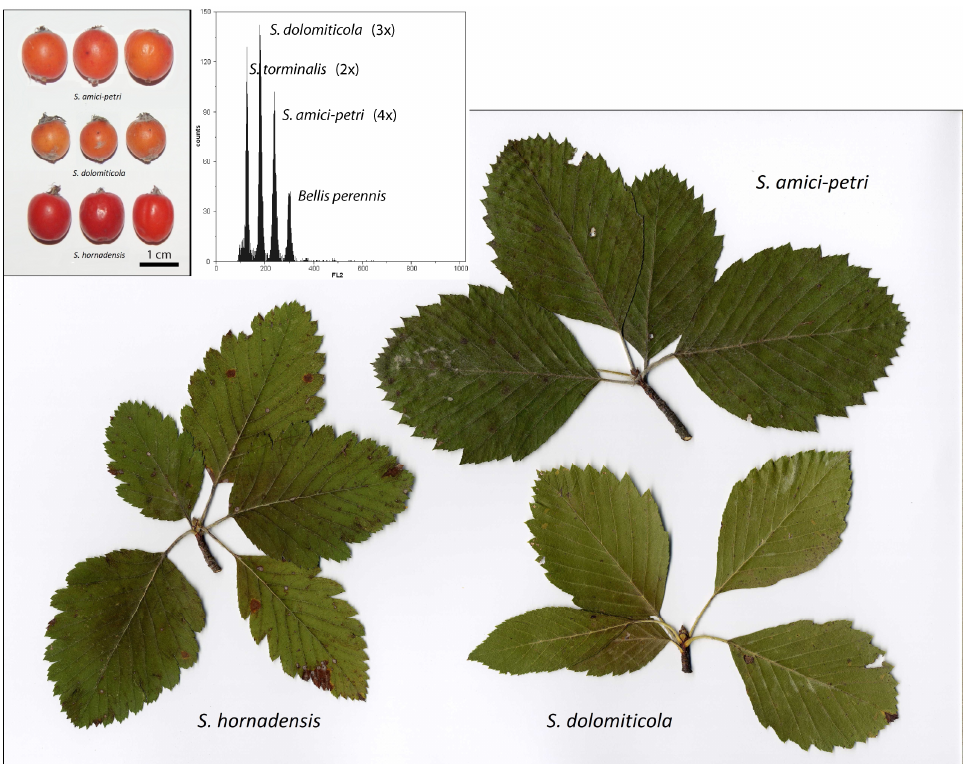
Figure 1. Three stenoendemic (taxon having very restricted distribution range) Sorbus species growing in eastern Slovakia (Central Europe) investigated in the present study. Leaves of short, sterile brachyblast and fruits (left inset) enabled precise identification of the species in the field. Example of flow cytometry (FCM) histogram (right inset) documenting variation in DNA content (relative fluorescence on x -axis) among different cytotypes: diploid S. torminalis , triploid S. dolomiticola , and tetraploid S. amici-petri . In FCM analyses, Bellis perennis L. was used as an internal reference standard. Note, S. hornadensis is also tetraploid.